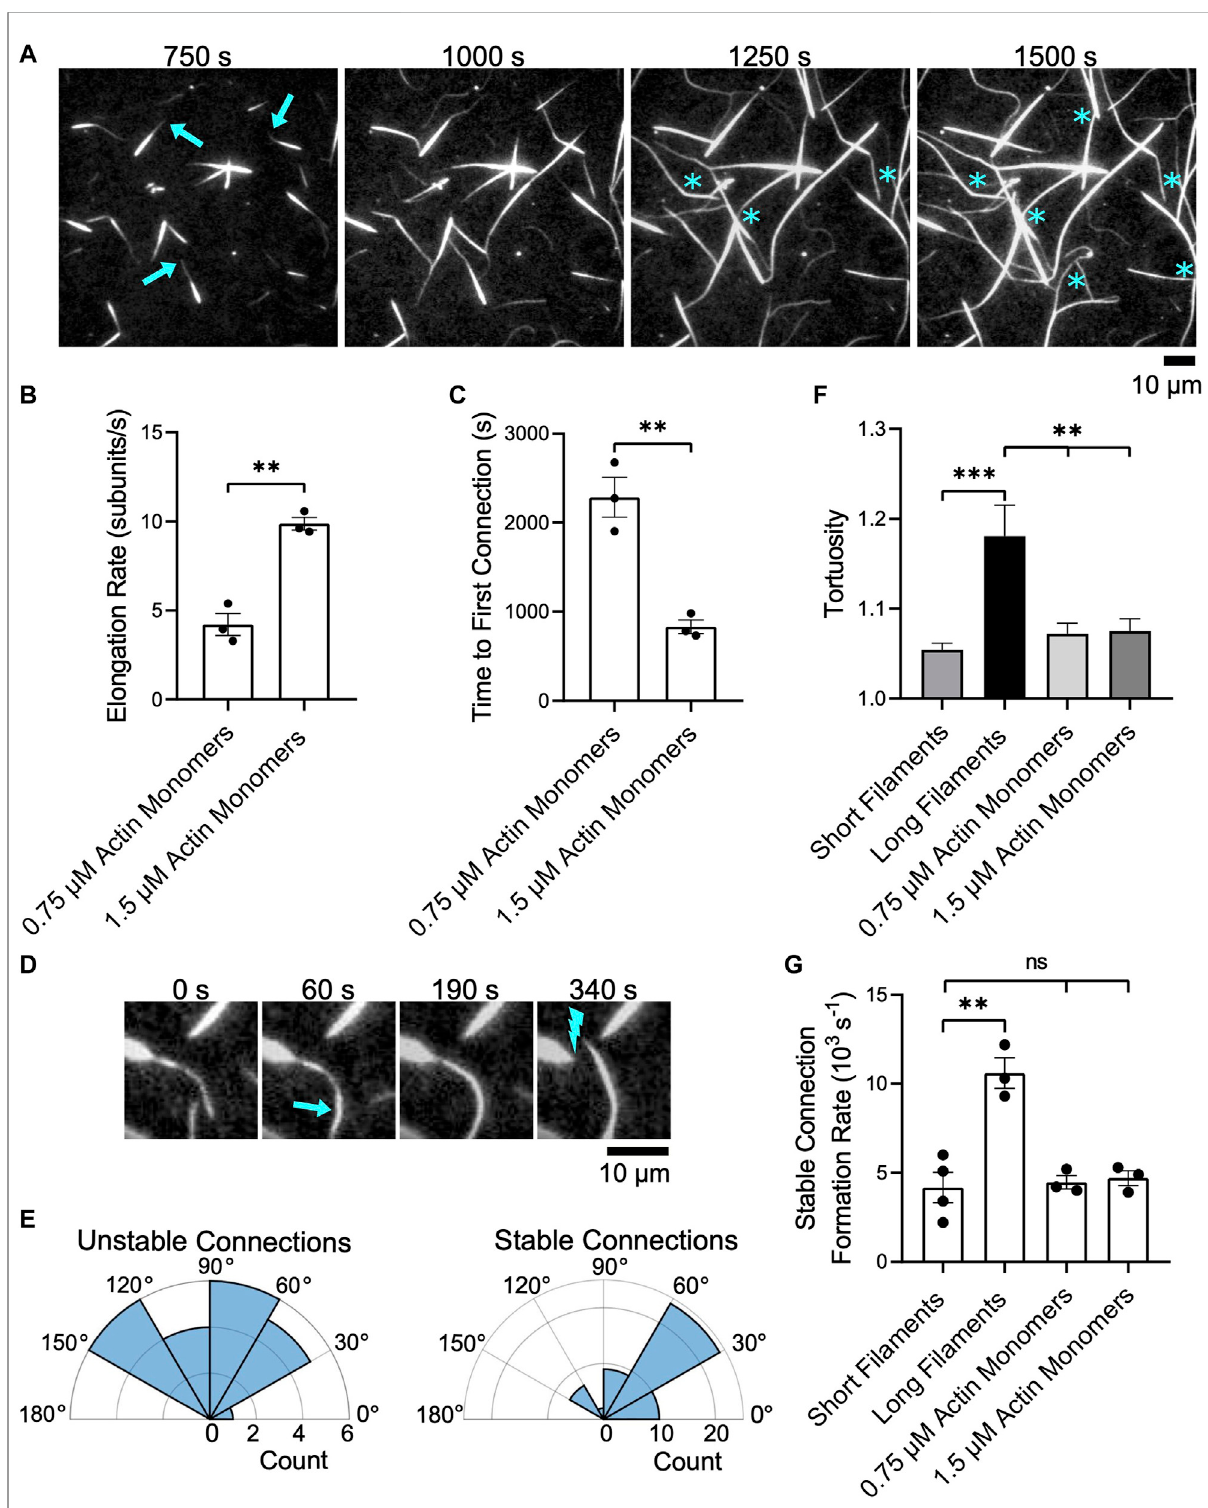
FIGURE 6 Bundlesofshort fi lamentsremaindiscretewhileelongating.FilamentswereassembledinthepresenceofCdc12p,labeledwithFITC-phalloidin and bundled by 1 µM fascin. Bundles were visualized by TIRF microscopy following the introduction of 0.75 or 1.5 µM actin monomers (5% Oregon Green-labeled), 10 µM S. pombe pro fi lin, and 1 µM additional fascin. In all plots, asterisks indicate statistical signi fi cance (** indicates p < 0.01; ***